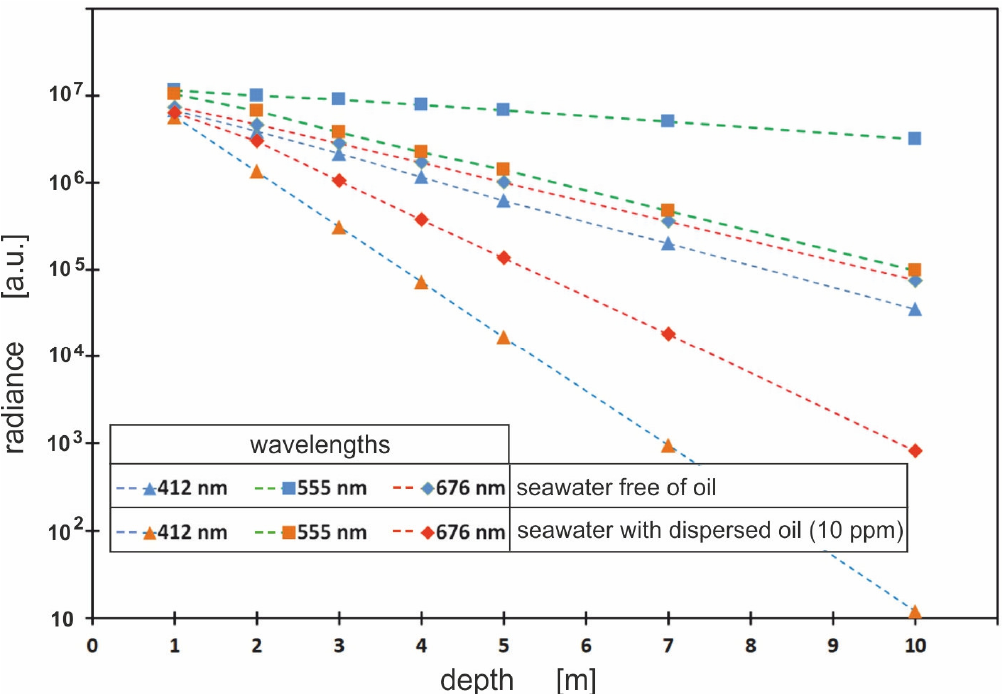
Figure 5 . The values of radiance under the sea surface (for chosen wavelengths: 412 nm, 555 nm and 676 nm at seven depths: 1 m, 2 m, 3 m, 4 m, 5 m, 7 m and 10 m), for unpolluted seawater (blue tags) and seawater polluted with a Baltic-type crude oil emulsion (10 ppm) (red tags).